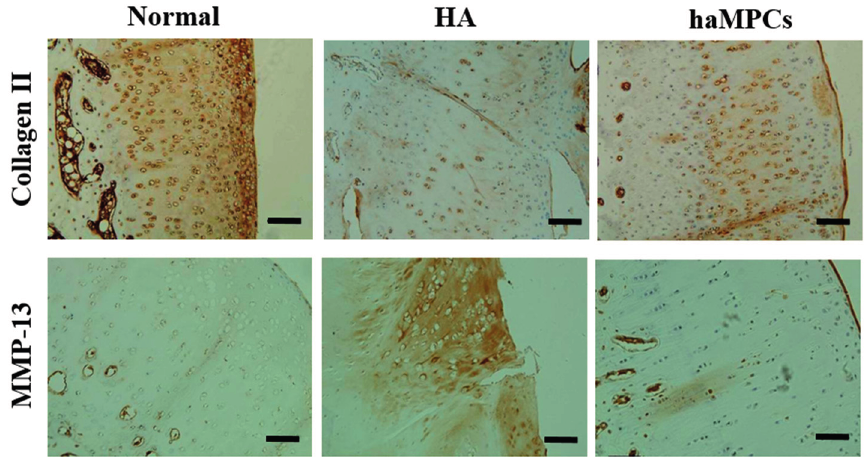
Figure 5. Immunostaining of type II collagen and MMP-13. The haMPC treatment increased articular cartilage type II collagen expression and decreased articular cartilage MMP-13 secretion. Scale bars = 50 μ m.